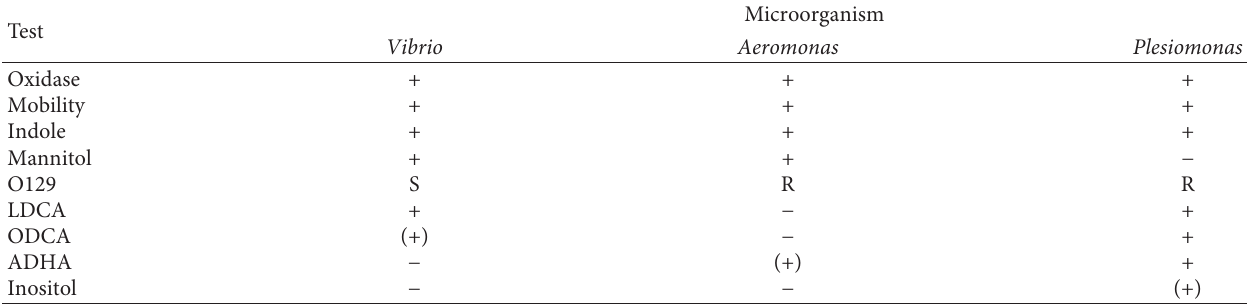
Table 2: Biochemical identification among Plesiomonas, Vibrio , and Aeromonas bacteria present in fish and fish products [29–32,